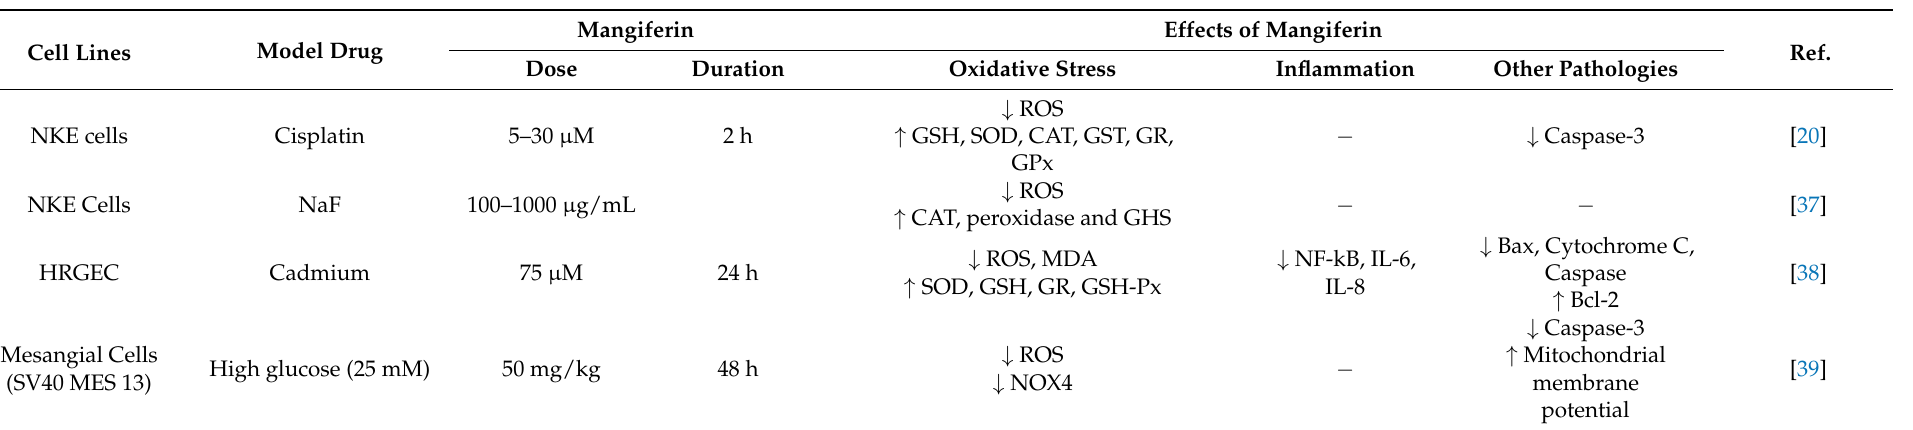
Table 2. In vitro renoprotective effects of